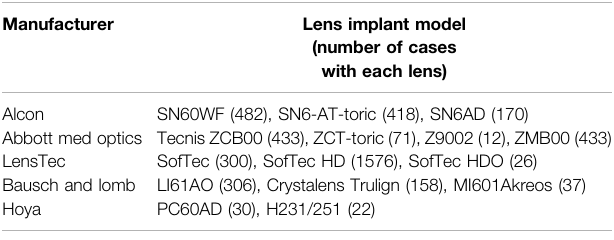
TABLE1| Manufacturersandlensesusedinourdatasetwiththenumberofcases with each lens. Some of these cases were excluded from the study due